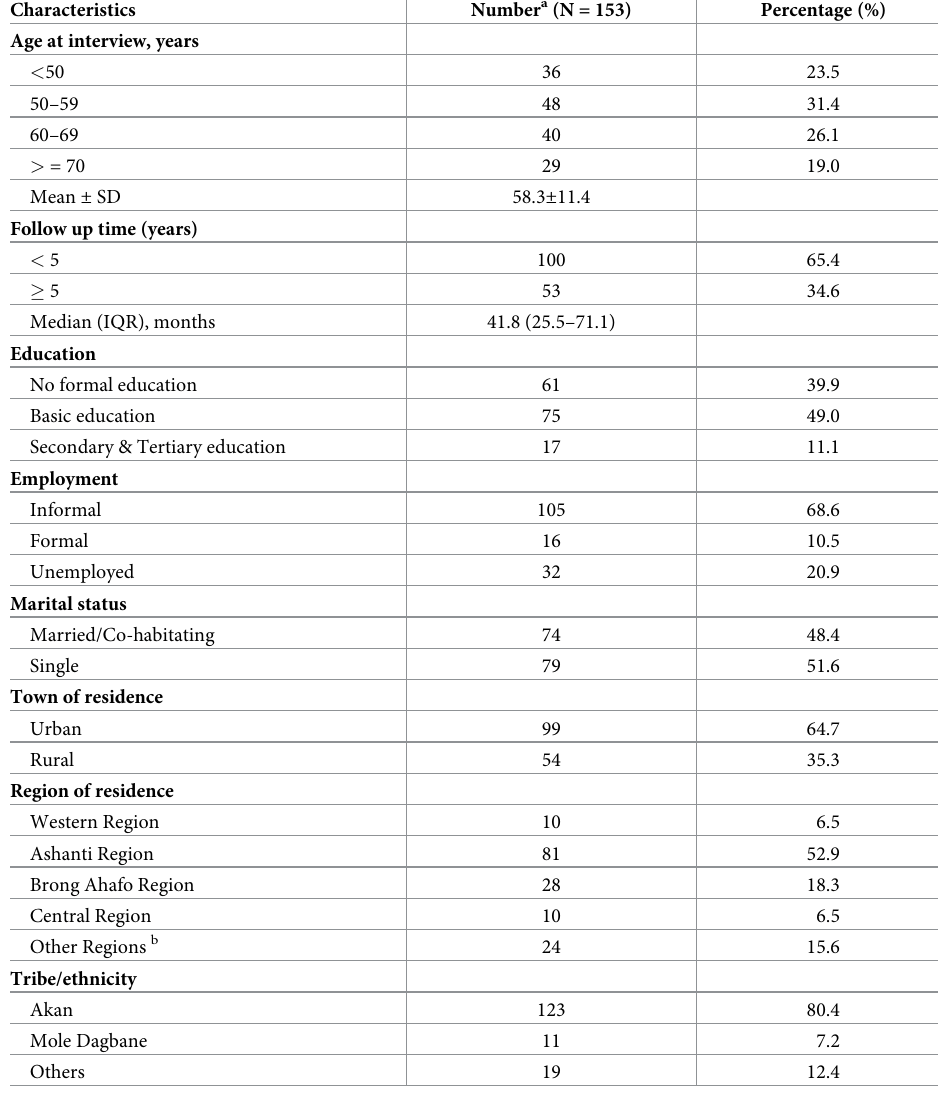
Table 1. Sociodemographic characteristics of cervical cancer survivors after